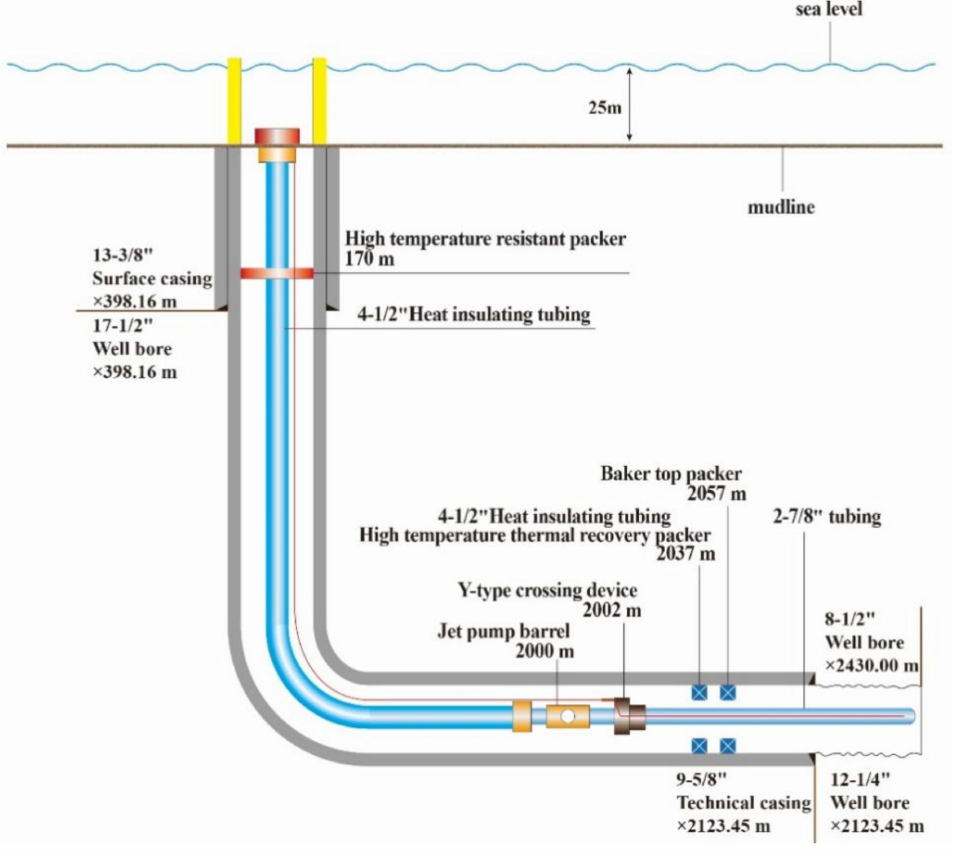
Figure 6. Well structure for Well X. Table 1. Basic operating parameters.